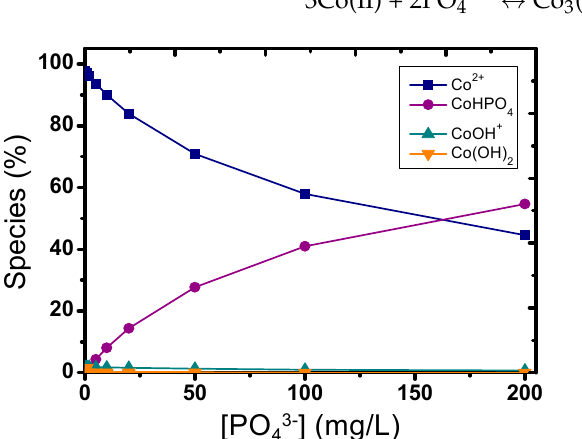
Figure 4. The soluble species of Co(II), according to the concentrations of PO 4 3 − in the solution. Initial Co(II) concentration 1 mg/L and pH 7.8 (data obtained with the application of Visual MINTEQ version 3.0 software).